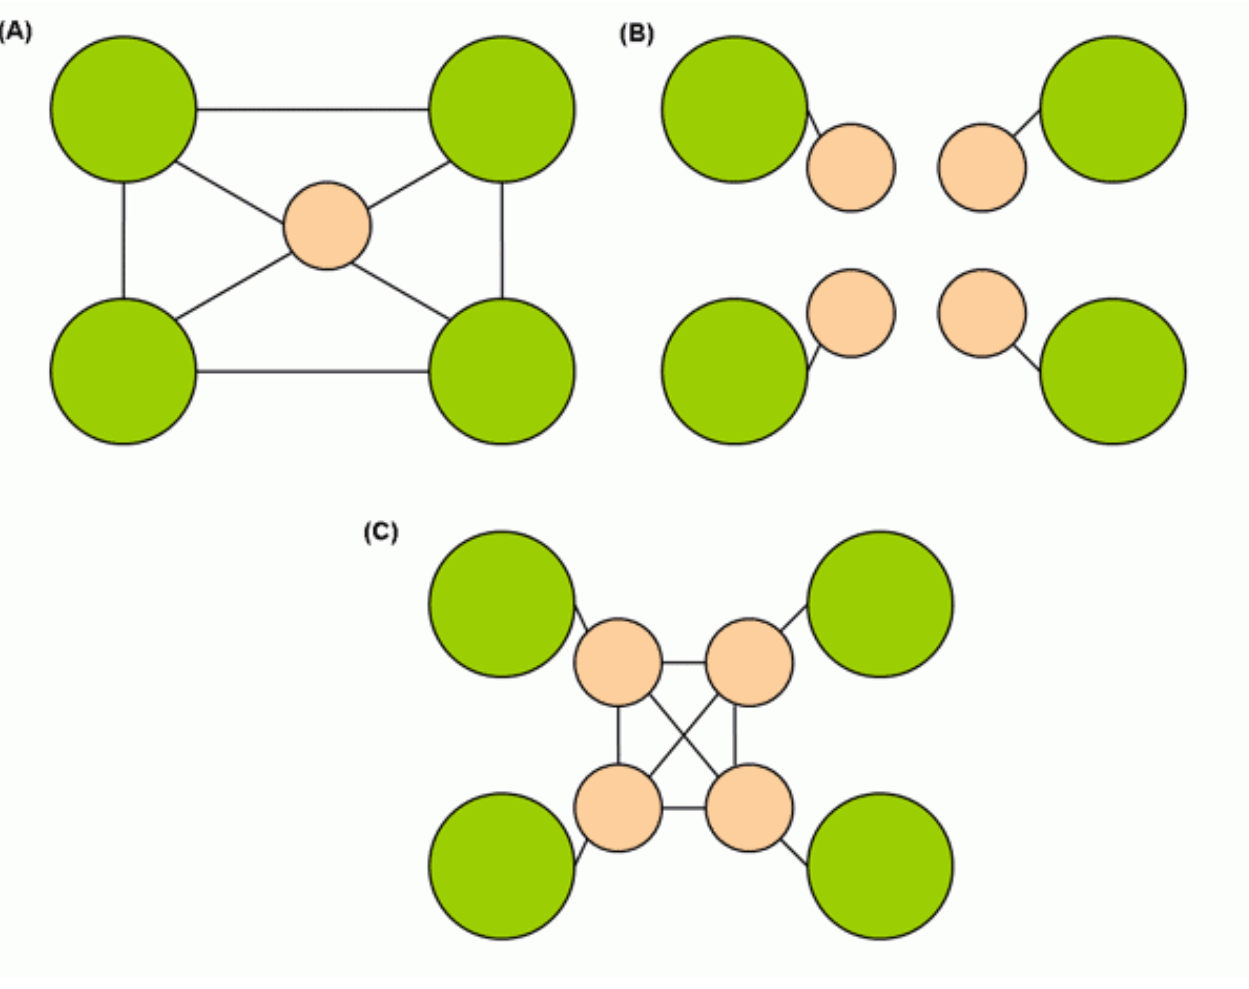
Fig. 3 . Development of agistment networks in Australian rangelands. Large circles represent ecological subsystems; small circles, pastoral enterprises. (A) Open-range system with very large unfenced paddocks, uneven distribution of stock grazing pressure around watering points, and a high degree of natural drought- buffering capacity. (B) Fragmented system with more intense and evenly distributed grazing pressure and reduced natural drought-buffering capacity. (C) Fragmented system with agistment in which informal networks have developed to partially increase the scale of